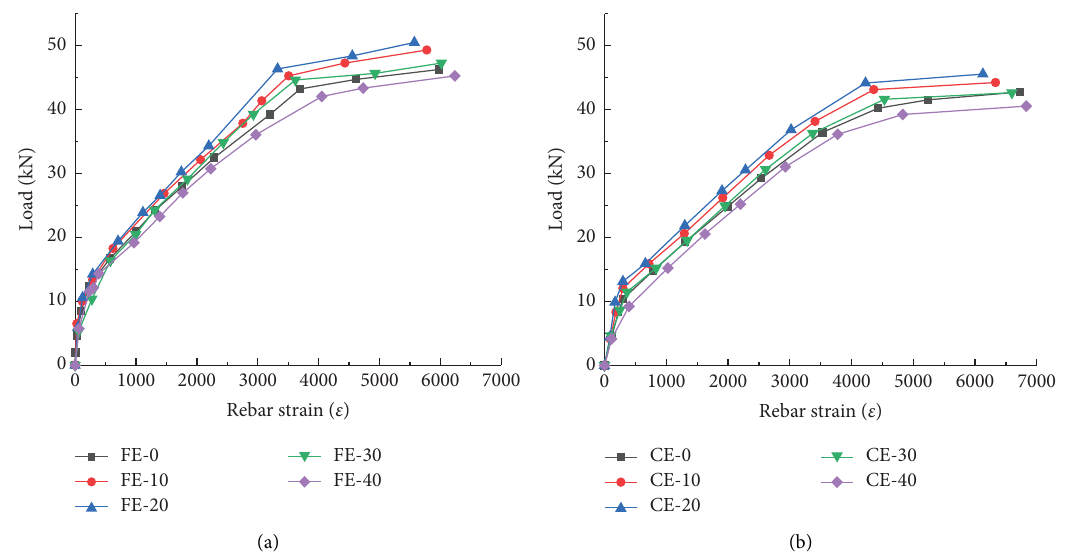
Figure 10: Strain-load curve of the longitudinal tensile steel bar in the middle of each test beam. (a) Fresh water environment and (b) chloride environment.